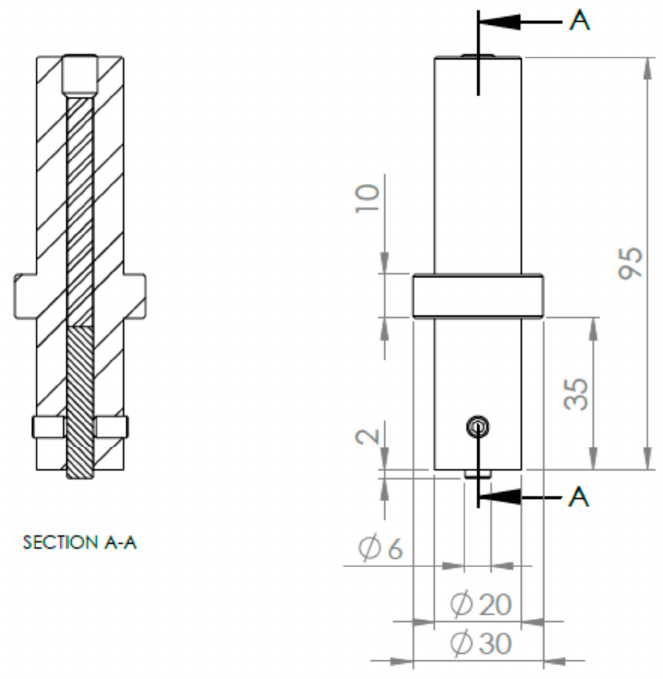
Figure 1. The welding tool.